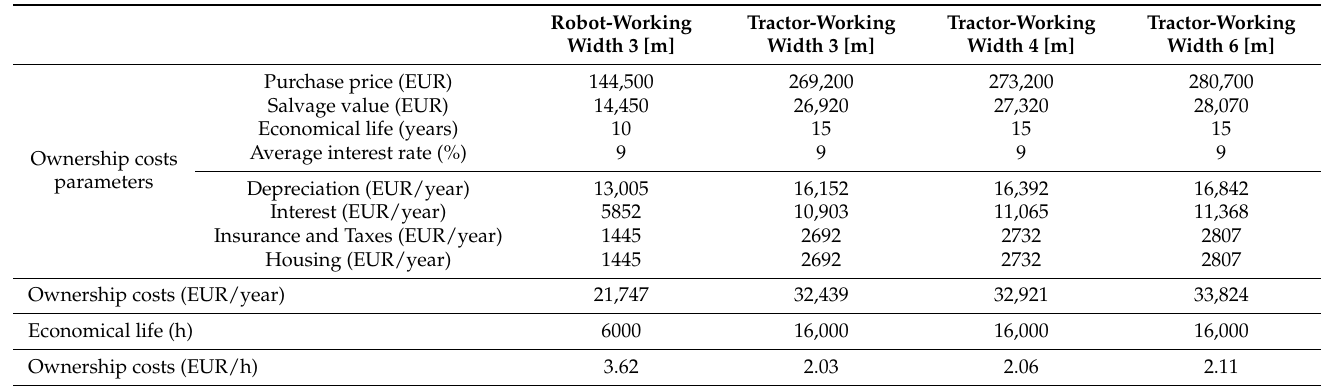
Table 4. The calculation of ownership costs for robotic and conventional machinery in seeding operation.